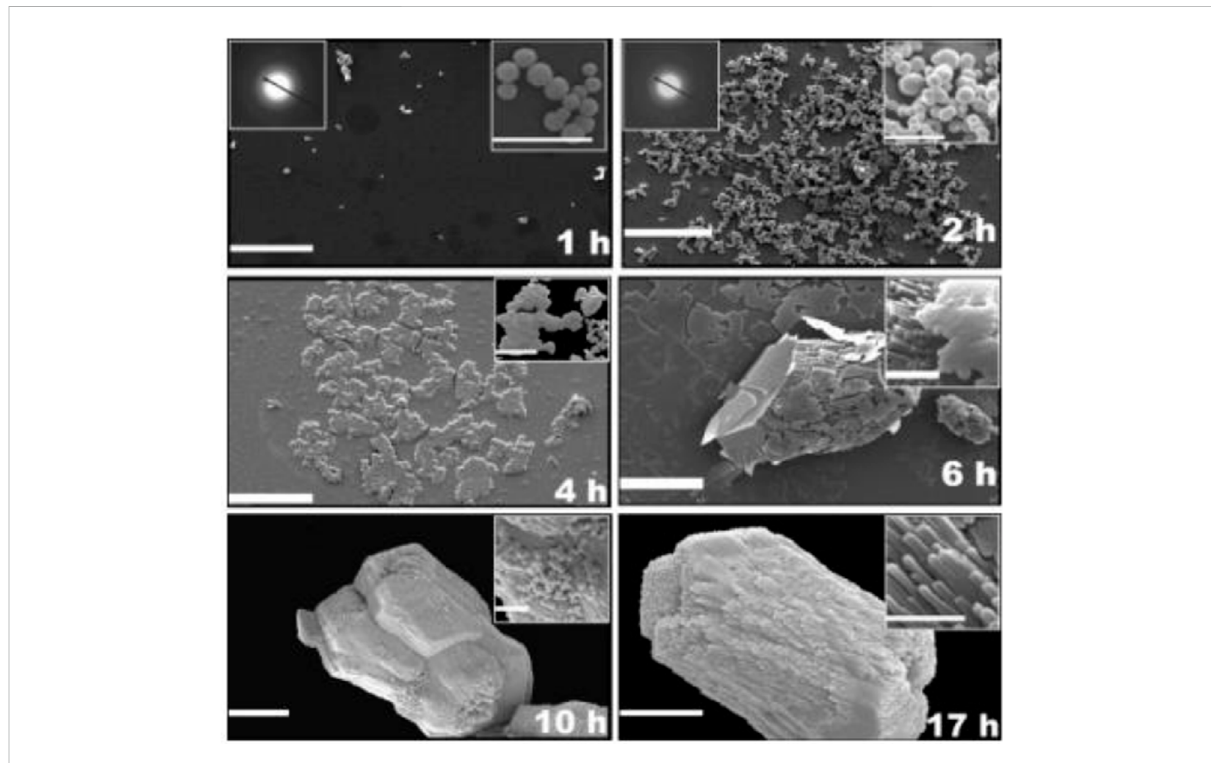
FIGURE 4 SEM micrographs of the calcium carbonate grown by the precipitation experiment at various time intervals. Scale bar and inset scale bar are 10 µm and 2 µm, respectively. Reproduced with permission from Lakshminarayanan et al. (2006), American Chemical